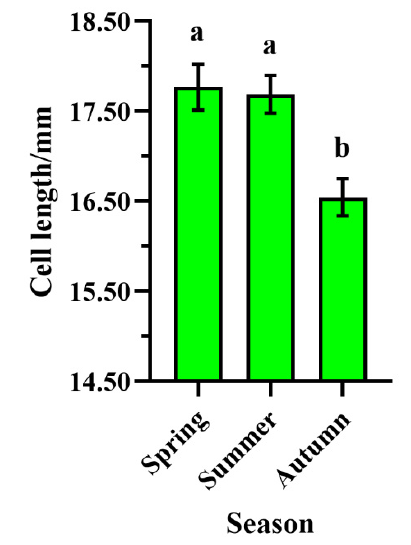
Fig 5 . Comparison of length between mouth and bottom of swarm